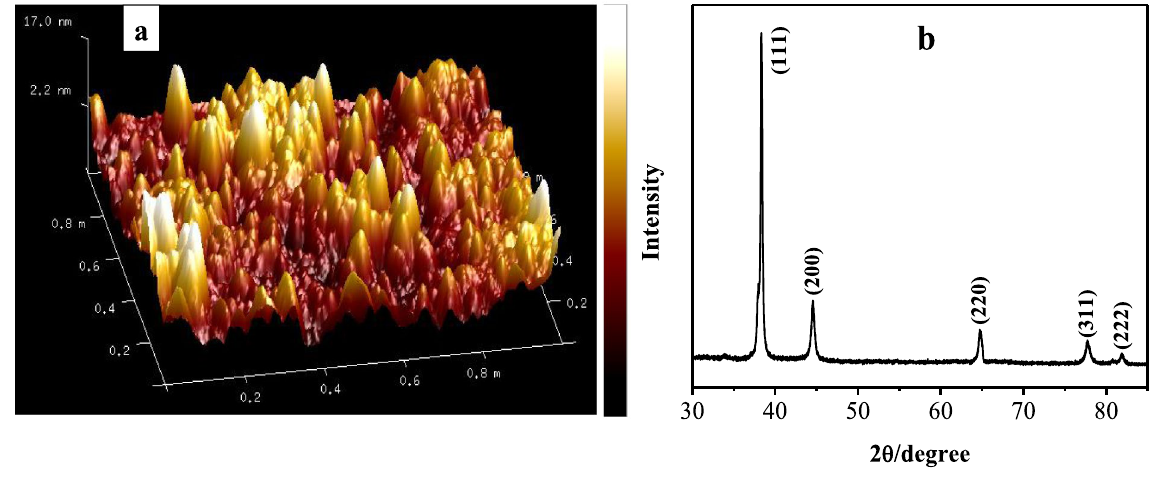
Fig. 1 a Atomic force microscopy (AFM) images of 150 nm Au film, b X-Ray Diffraction (XRD) analysis of the as-deposited Au